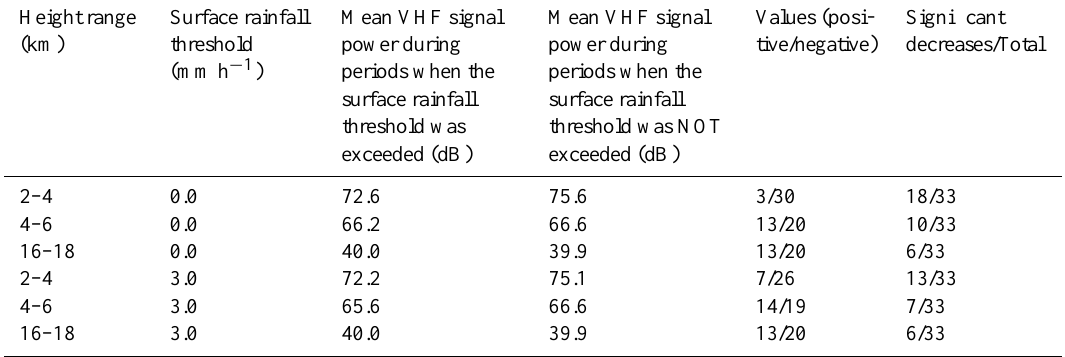
Table 4. The mean VHF signal power is shown averaged over the height range indicated during periods where the indicated rainfall threshold was and was not exceeded. In addition, the number of positive and negative changes are shown in the mean signal power associated with rainfall as well as the number of significant decreases in the signal power associated with periods of surface rainfall above the indicated threshold. The surface rainfall is observed by a tipping bucket rain gauge co-located with the VHF